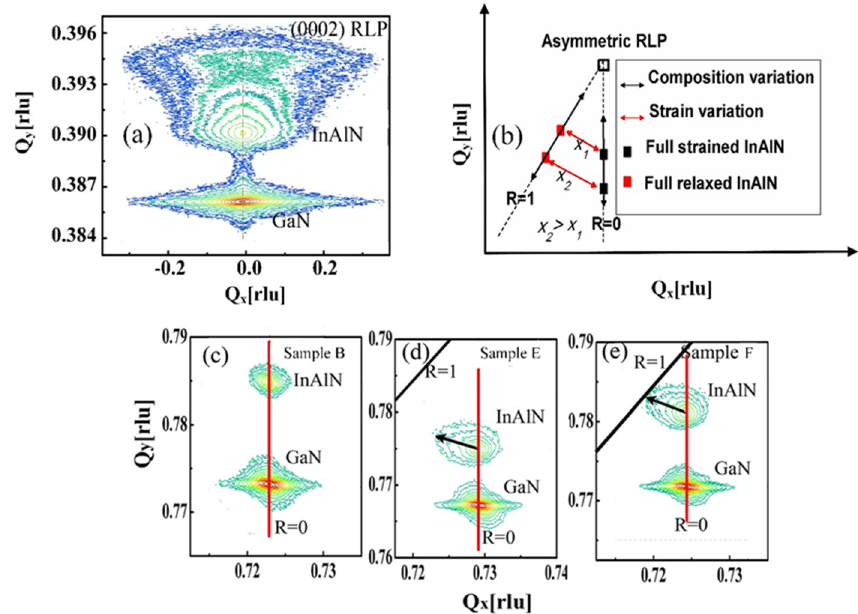
Figure 2. ( a ) RSM around the GaN (0002) RLP of sample B; ( b ) RSM stress analysis schematic; ( c–e ) RSMs around (2024) reciprocal lattice point of sample B, E, and F.